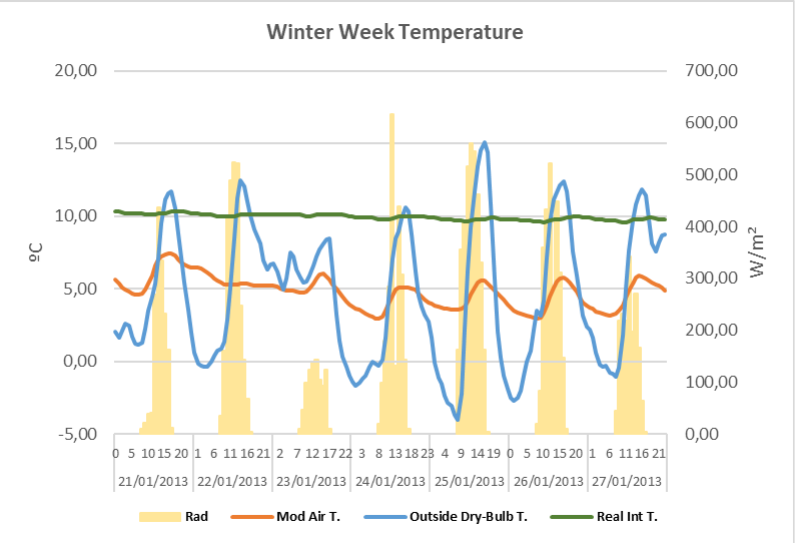
Figure 23. Hourly solar radiation, outdoor temperatures, and real and modeled indoor temperatures (winter).